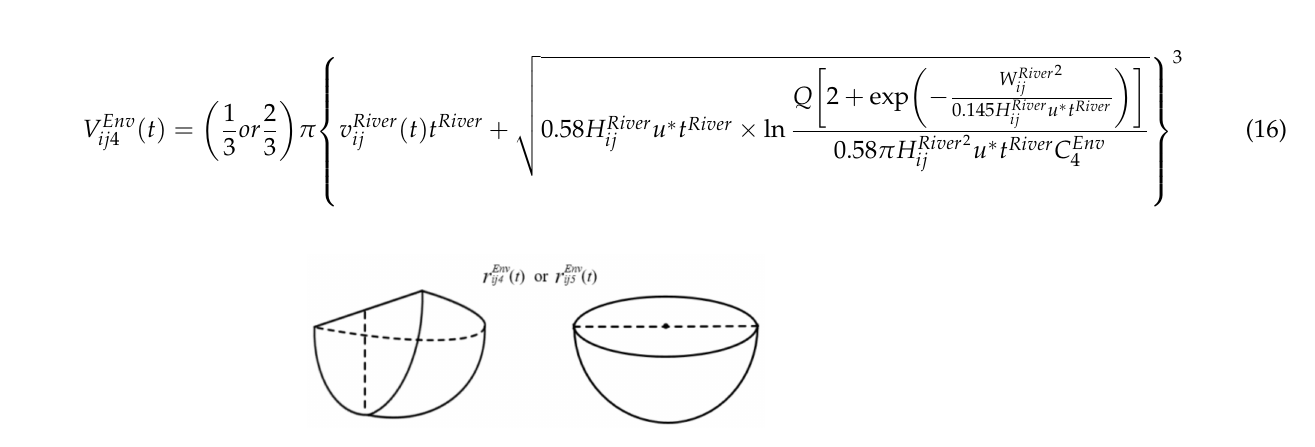
Figure 4. Accident influence area of lake and river